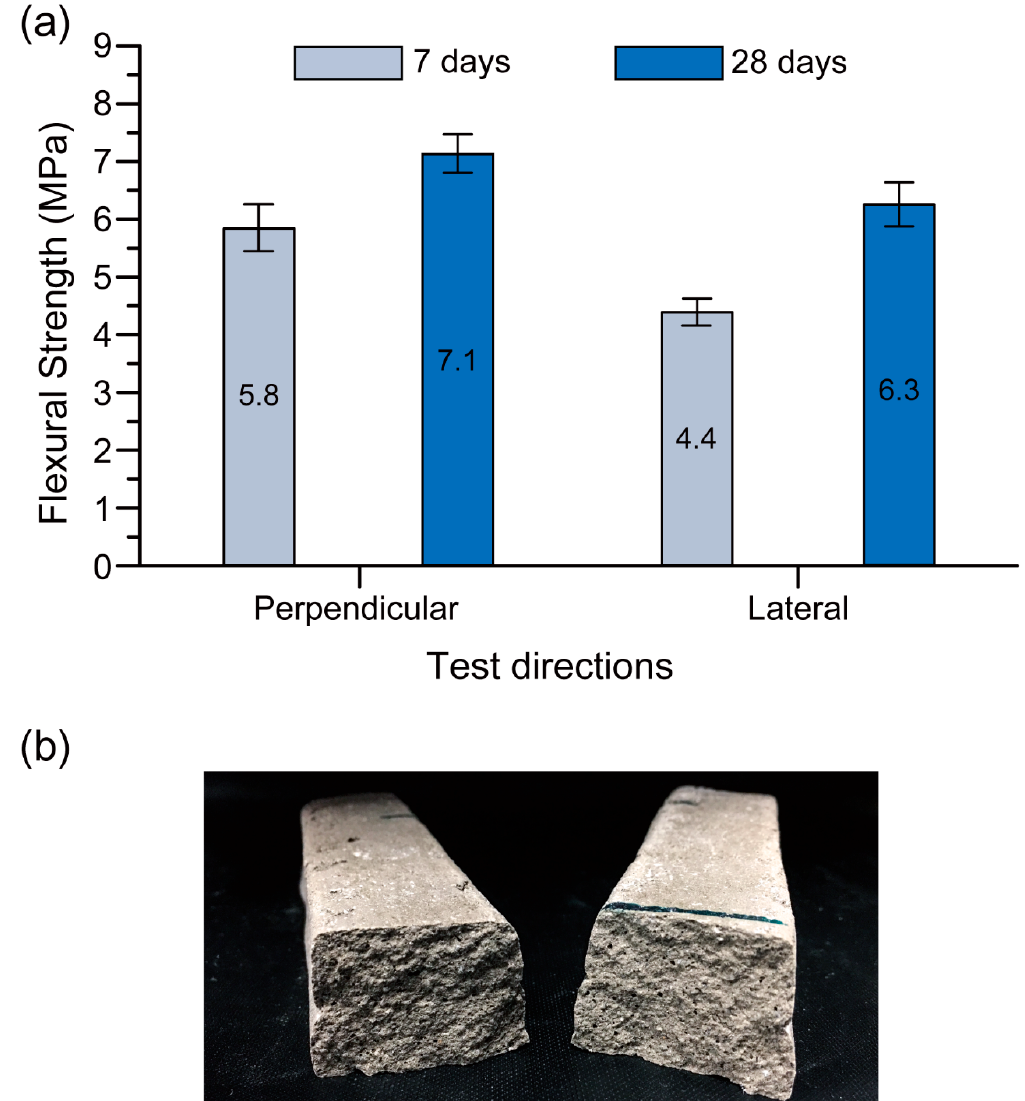
Figure 12. ( a ) Flexural strength of Na-N-2.5 (the optimum 3D printable mixture) in different directions. ( b ) Side view of the fractured surfaces.